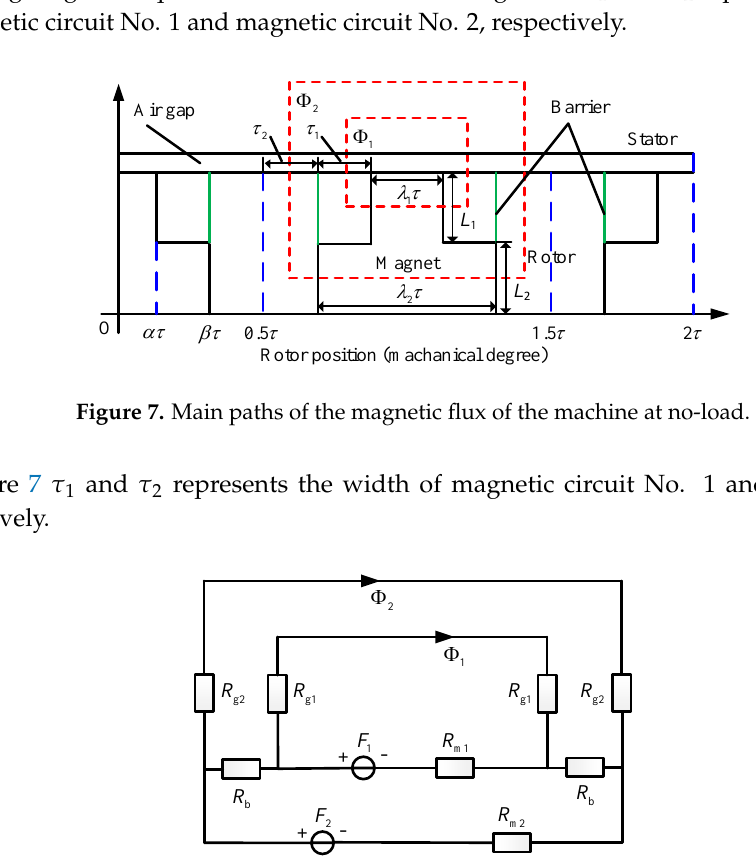
Figure 8. Equivalent magnetic circuit.